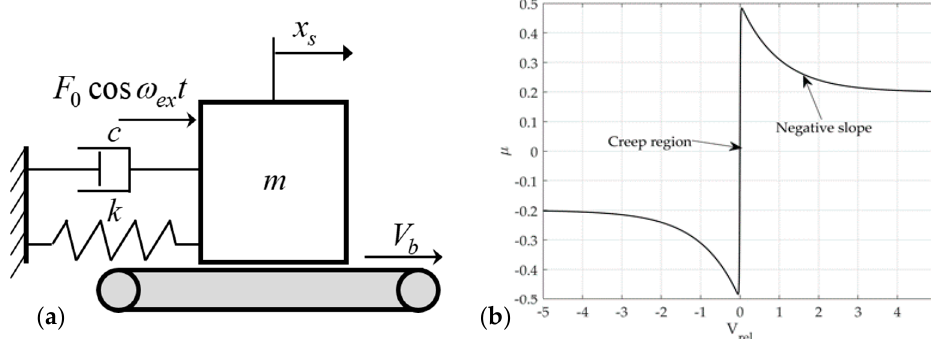
Figure 2. Single-mode squeak model: ( a ) 1-D model ( b ) friction–velocity